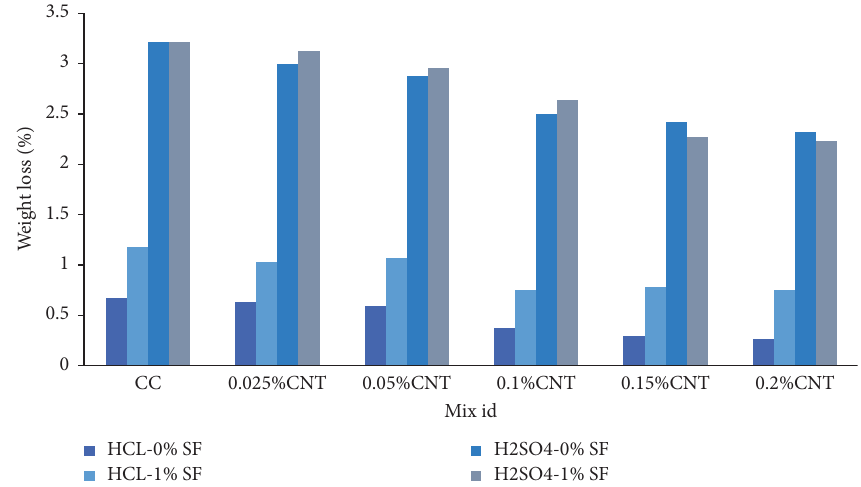
Figure 17: Weight loss % with steel fbres.